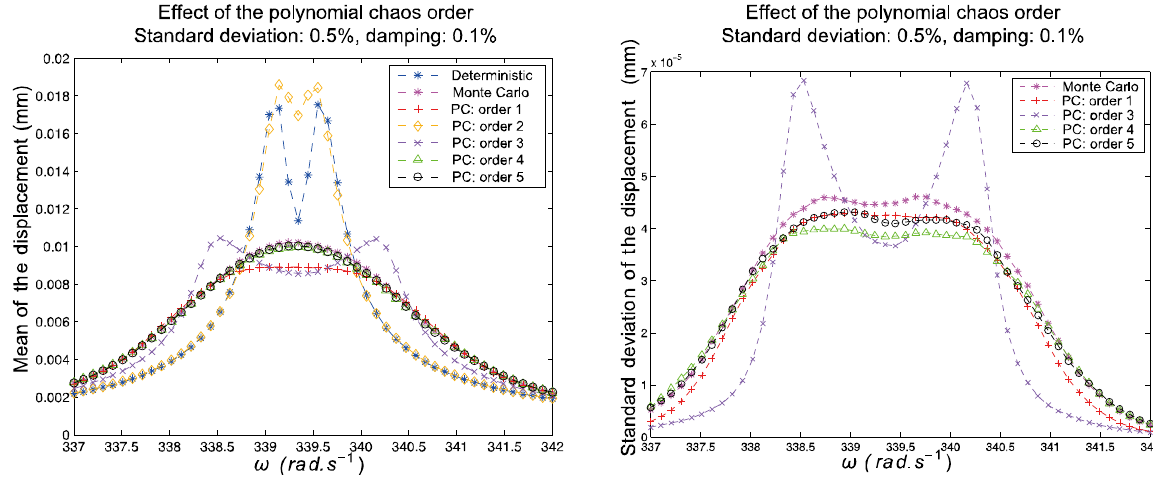
Fig. 6. Forced response: mean of the displacement of the 1st blade flexural dof (left) and relative discrepancy in comparison to Monte Carlo (right) − Effect of the polynomial chaos